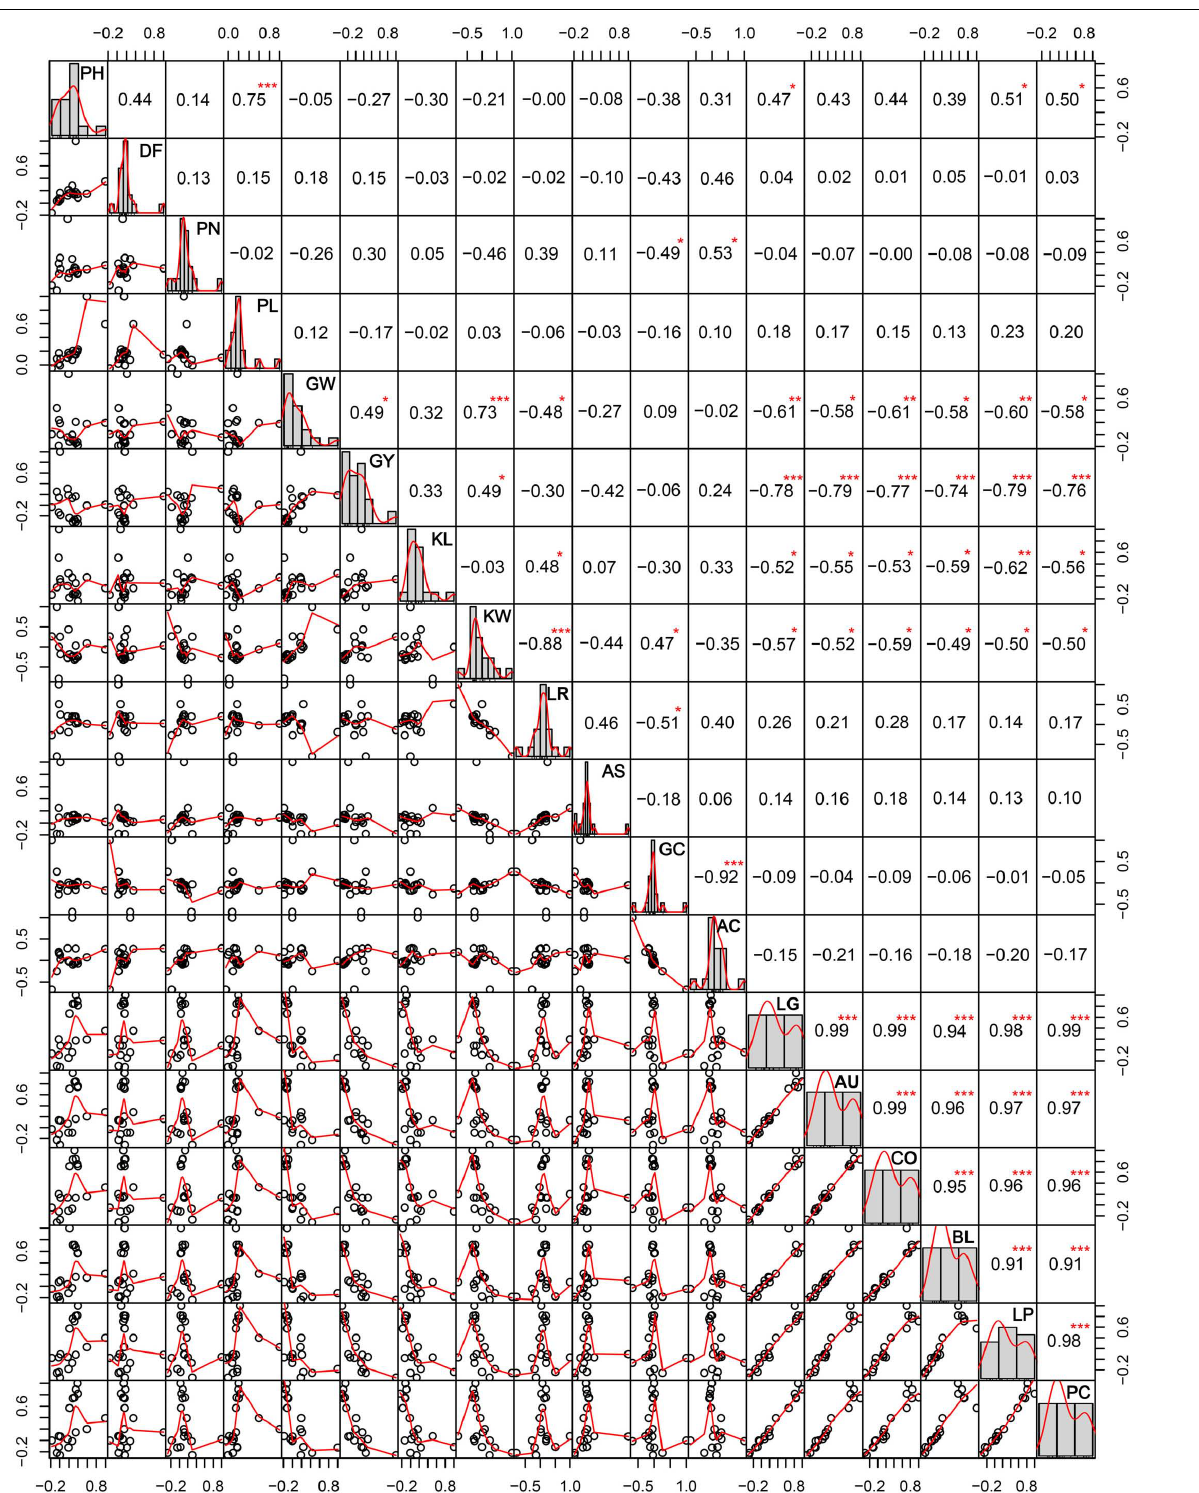
Frontiers in Genetics |